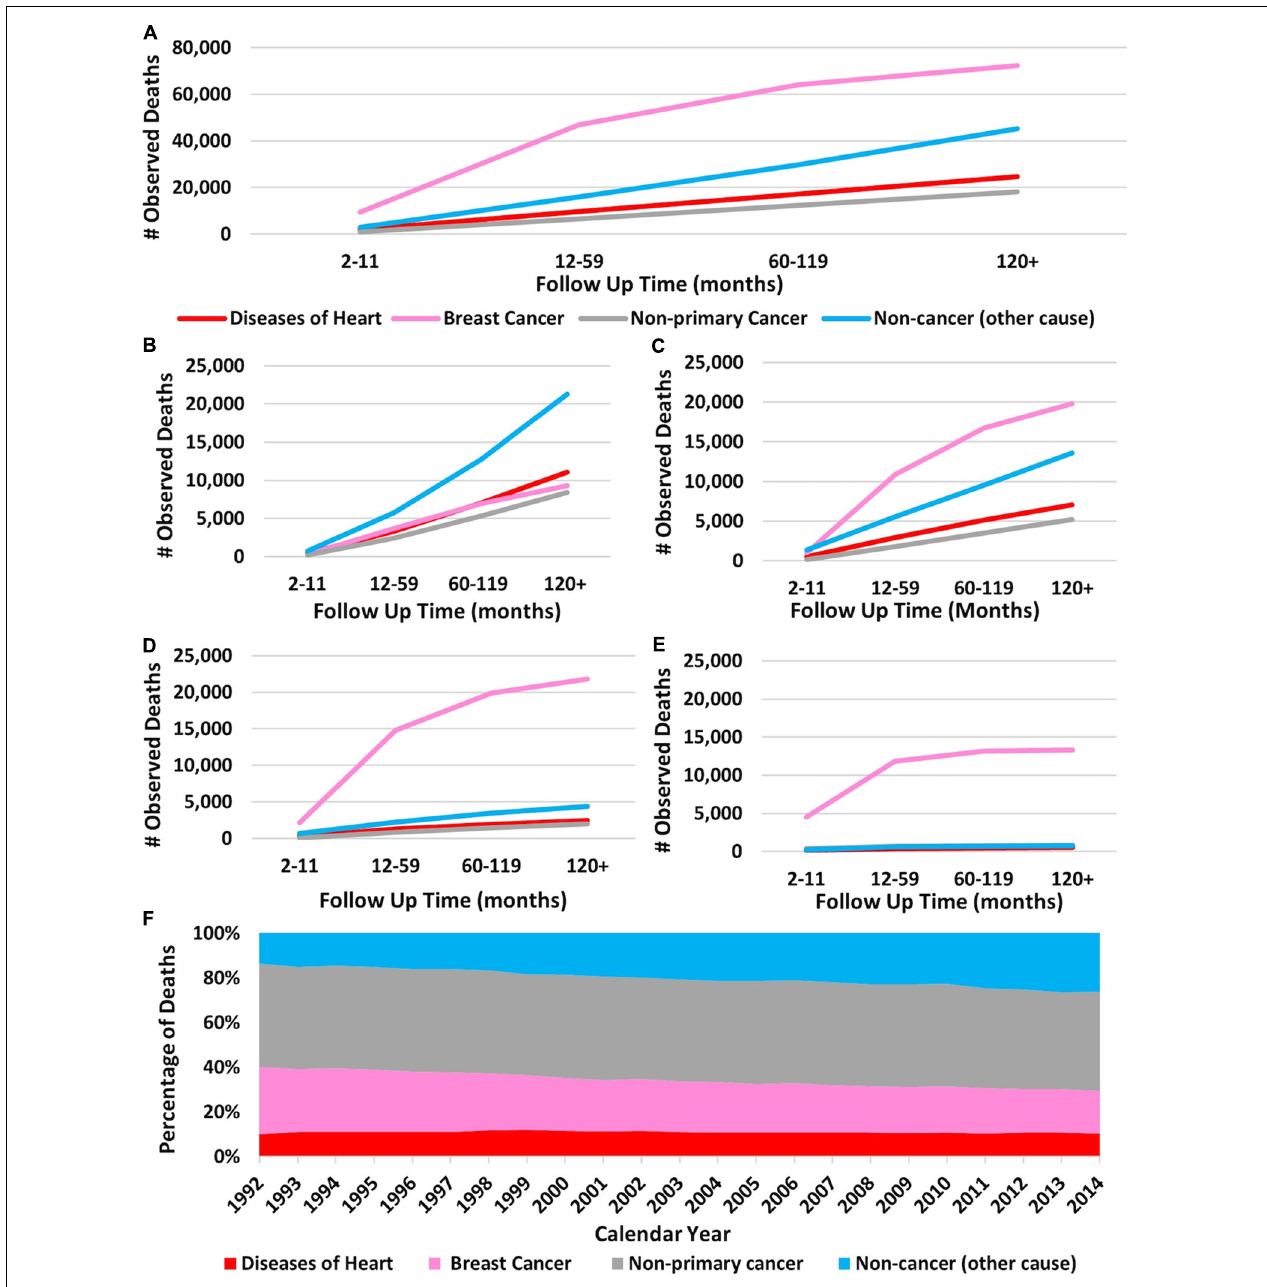
FIGURE 2 | Cumulative death in breast cancer patients over time broken down by cause of death and stage of disease. The Y -axis of each panel shows the observed number of deaths and the X -axis shows the time since diagnosis in months. Each line represents a specific cause of death with the following colors: red, heart disease; pink, breast cancer; gray, non-primary cancer; and blue, non-cancer cause. (A) Cumulative number of deaths in all breast cancer patients (regardless of stage) separated by cause of death over time. Breast cancer was the leading cause of death at all time points. (B) Cause of death in stage I patients according to the Adjusted AJCC 6th Edition. (C) Cause of death in stage II patients. (D) Cause of death in stage III patients. (E) Cause of death in stage IV patients. Breast cancer was the leading cause of death in all patients, except those with stage 1 disease. Heart disease caused the most fatalities in stage I patients at 10+ years follow-up. Panel (F) shows the percentages of cause of death for each calendar year throughout the study period. The X -axis represents calendar years and the Y -axis represents percent of death per year. Pink represents breast cancer, gray is non-breast cancer, blue is non-cancer causes, and red is heart disease. Brest cancer accounts for the most deaths followed by non-cancer causes. As calendar year increases the percentage of patients dying from breast cancer decreases and the percentage of patients dying from non-cancer causes increases. Heart disease consistently accounts for at least 16% of cause of death. Panels (A–E) : generated from SEER Database: Incidence – SEER 13 Regs excluding AK Custom Data (with additional treatment fields), Nov 2016 Sub (1992–2014) for SMRs – Linked To County. MP-SIR session. Panel (F): generated from Incidence-Based Mortality – SEER 9 Regs Research Data, Nov 2018 Sub (1975–2016) < Katrina/Rita Population Adjustment > – Linked To County. Rate session